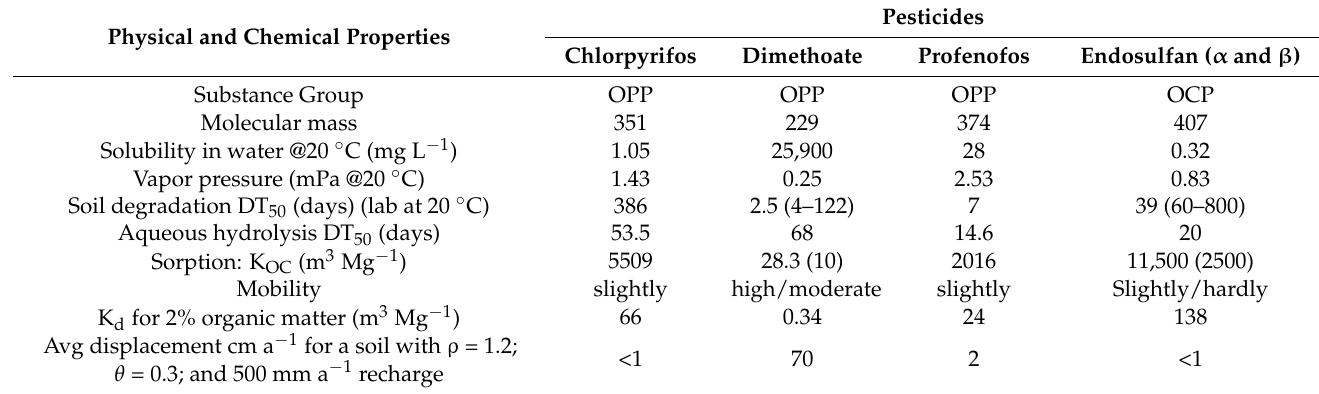
Table 2. The physical and chemical properties of active ingredients in farmer-applied pesticides in the Robit Bata watershed. Data were extracted from Pesticide Properties Database (PPDB) University of Hertfordshire, UK. Numbers in parentheses are from FAO